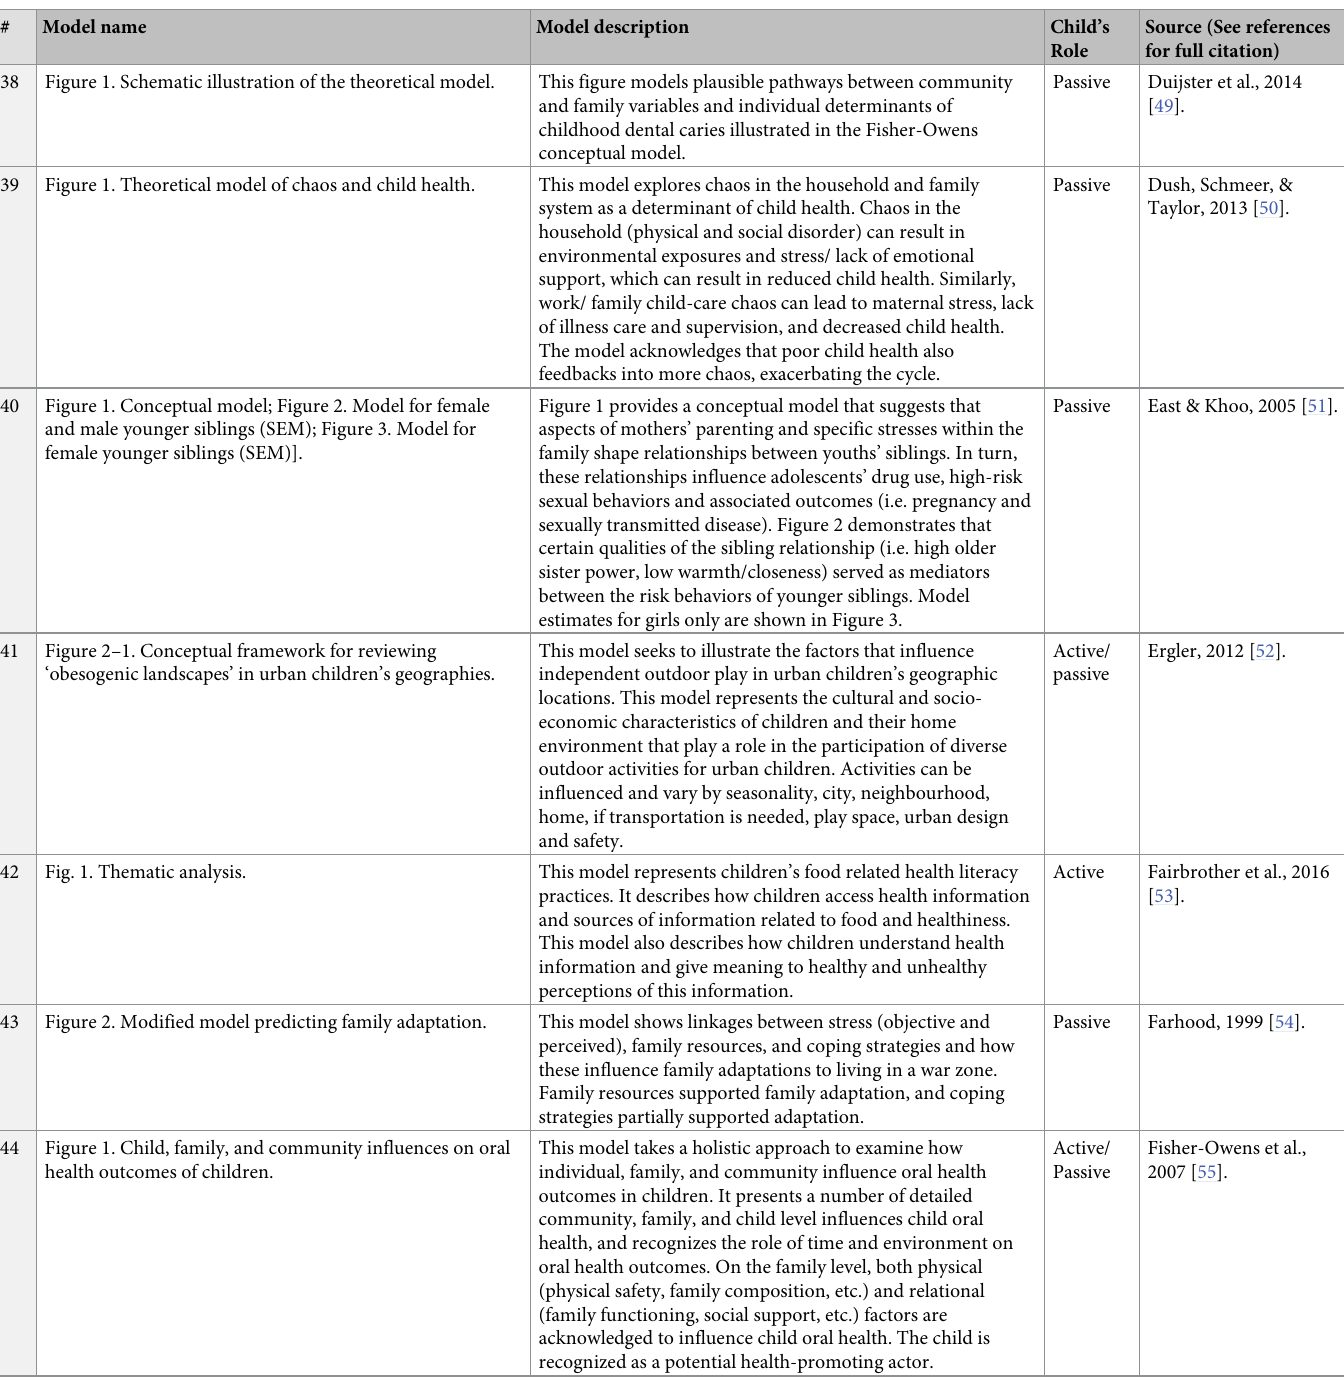
Figure 1. Schematic illustration of the theoretical model.